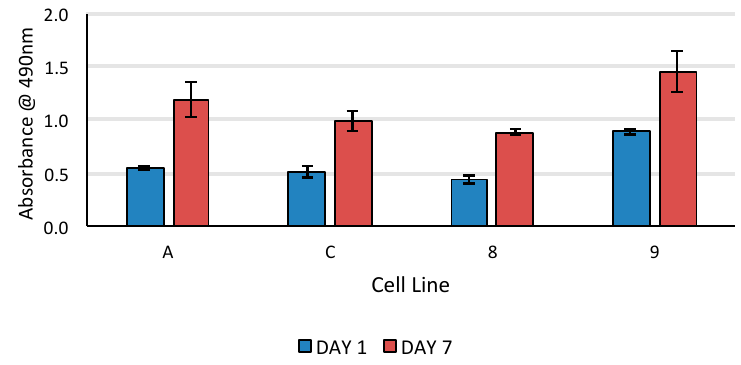
Figure 8. Cell proliferation as assessed by MTS in GMSC cultured on electrospun PCL scaffolds in 24 h and 7 days. There is clear evidence of cell proliferation over time irrespective of the health of donor gingival tissue even though there are differences in the degree of proliferation rates.